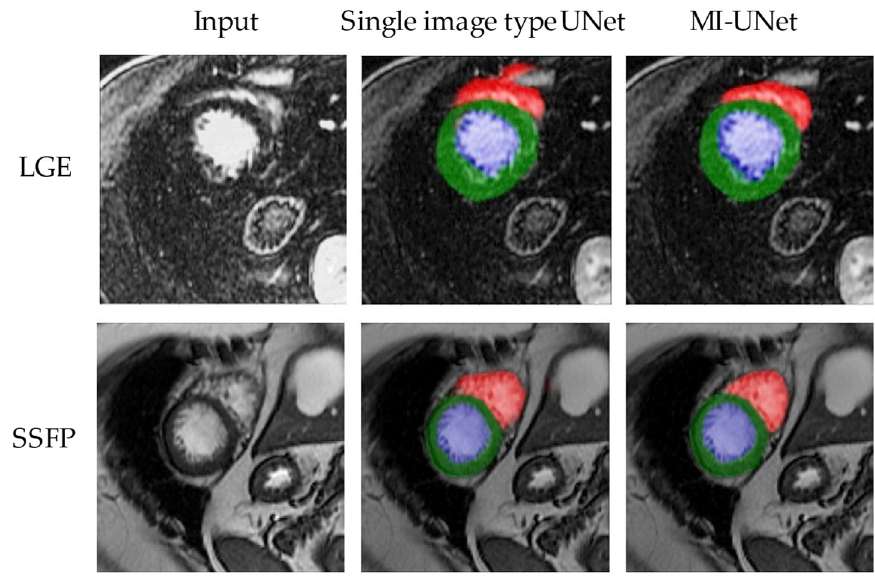
Figure 3. Example outputs of the segmentation models. Segments obtained from the proposed model compared with single-image type. In this figure, blue represents the left ventricular cavity, green the left ventricular wall, and red the right ventricle.